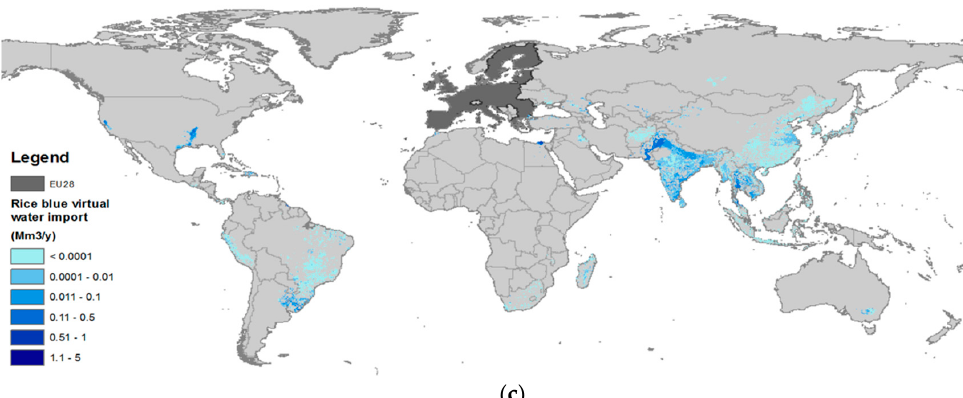
Figure 7. Blue virtual water imports to the EU per grid cell related to sugarcane ( a ), cotton ( b ) and rice ( c ) (million m 3 /year).